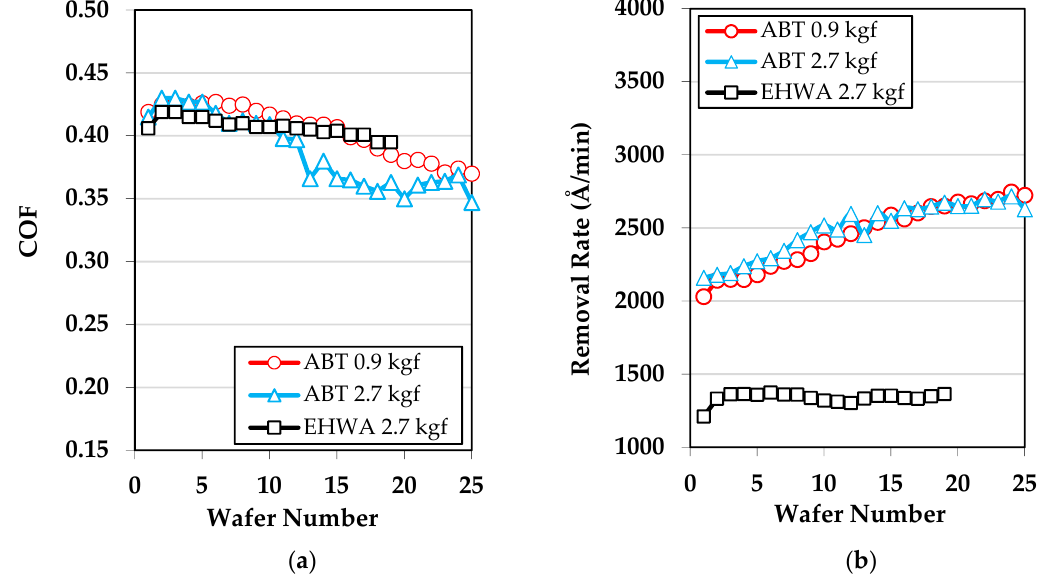
Figure 3. Surface height probability density functions (PDFs) corresponding to Figure 2.